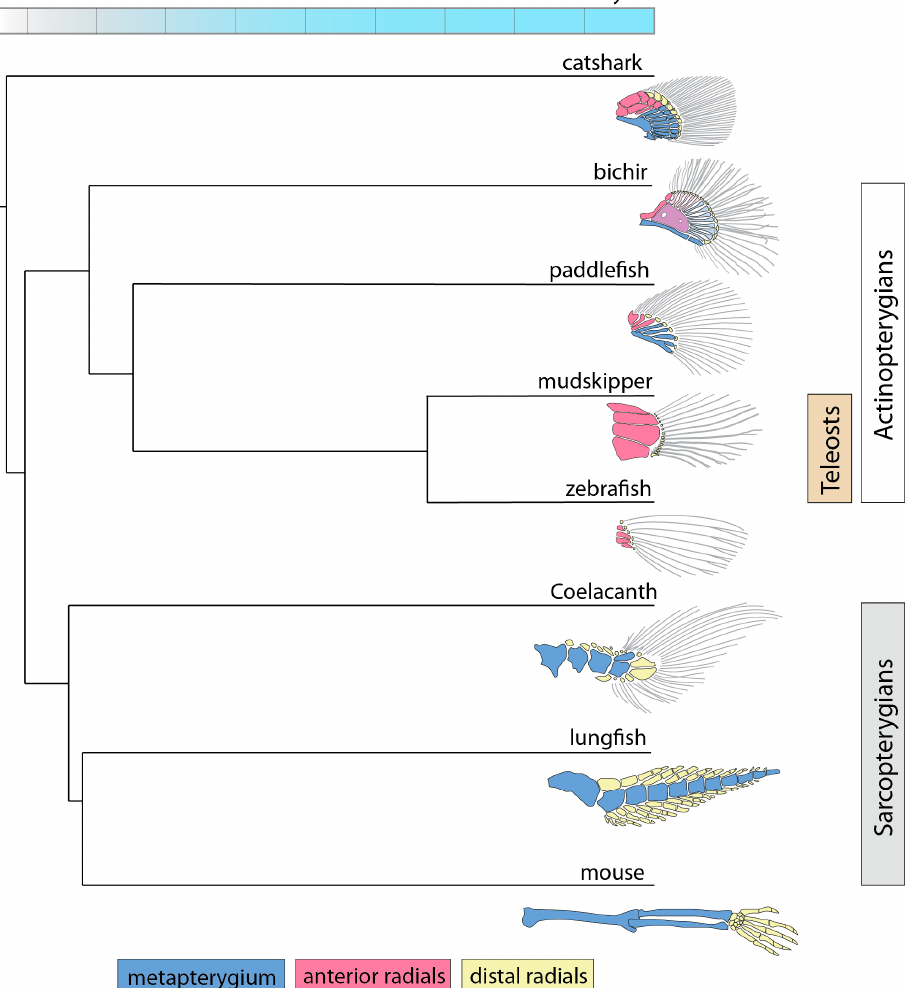
Figure 1. The homology of skeletal elements in the pectoral fins and forelimbs of selected vertebrates. The figure shows the phylogenetic relationships between different taxa, their estimated time of divergence, with the hypothesized homologous regions being highlighted with similar colors. Mya: million years ago. (Based on [27,28,34]).